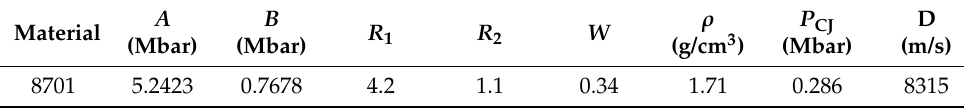
Table 3. The material parameters of the